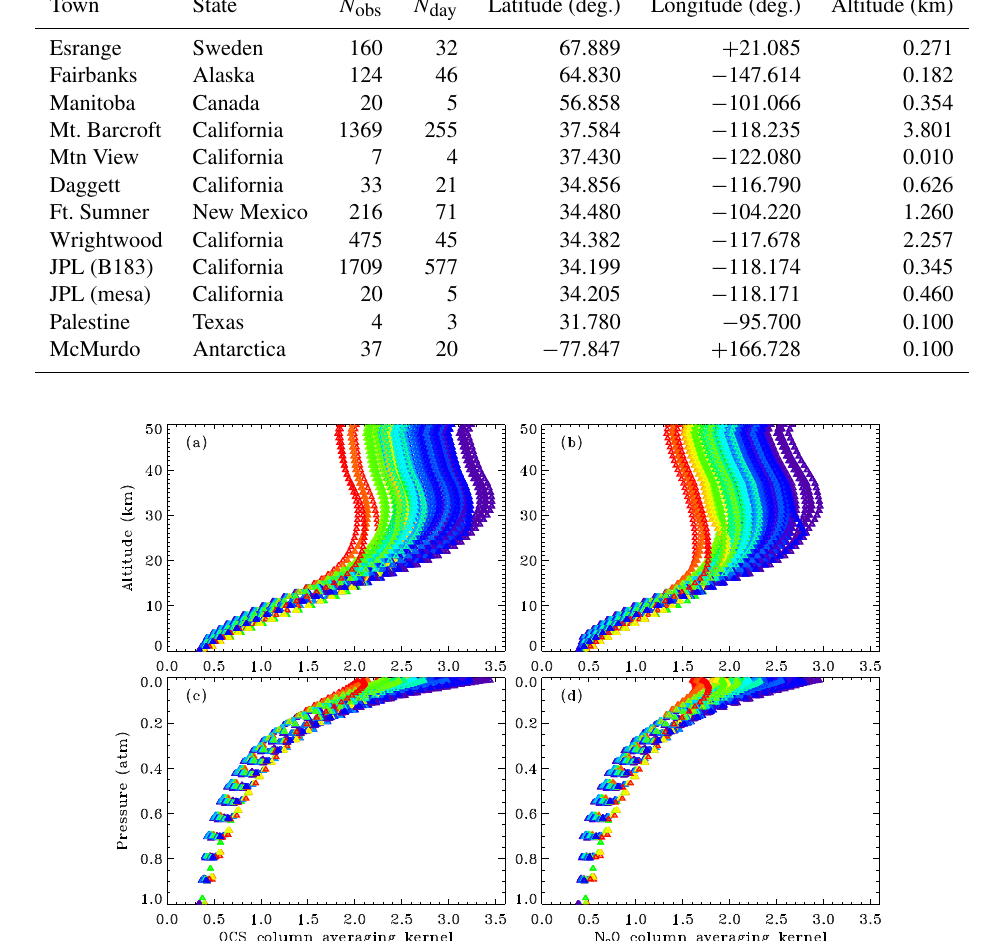
Figure 4. Ground-based column averaging kernels plotted versus altitude (a, b) and pressure (c, d) . Panels (a, c) show OCS kernels. Panels (b, d) show N 2 O kernels. Values are color-coded by air mass (purple: 1; green: 3; red: 10). A representative sub-set of 135 different observations, representing different sites and conditions, was used to make this plot. The fact that the OCS and N 2 O kernels are similar in shape is not a fortuitous accident. The N 2 O windows used in this study were selected to contain weak N 2 O lines only, matching the OCS lines in terms of line depth and hence kernel shape. Since the shapes of the OCS and N 2 O kernels are similar, so will be their sensitivity to stratospheric